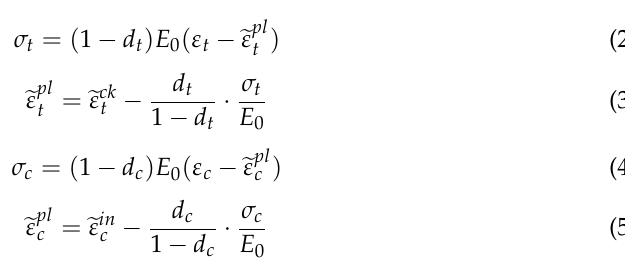
where, σ c and σ t are the compressive and tensile stresses; ε c and ε t are the compressive and tensile strains; E 0 is the initial elastic modulus; (cid:101) ε pl c and (cid:101) ε pl tensile strain; d c and d t are the compressive and tensile damage factors; (cid:101) ε in inelastic strain and cracking strain.